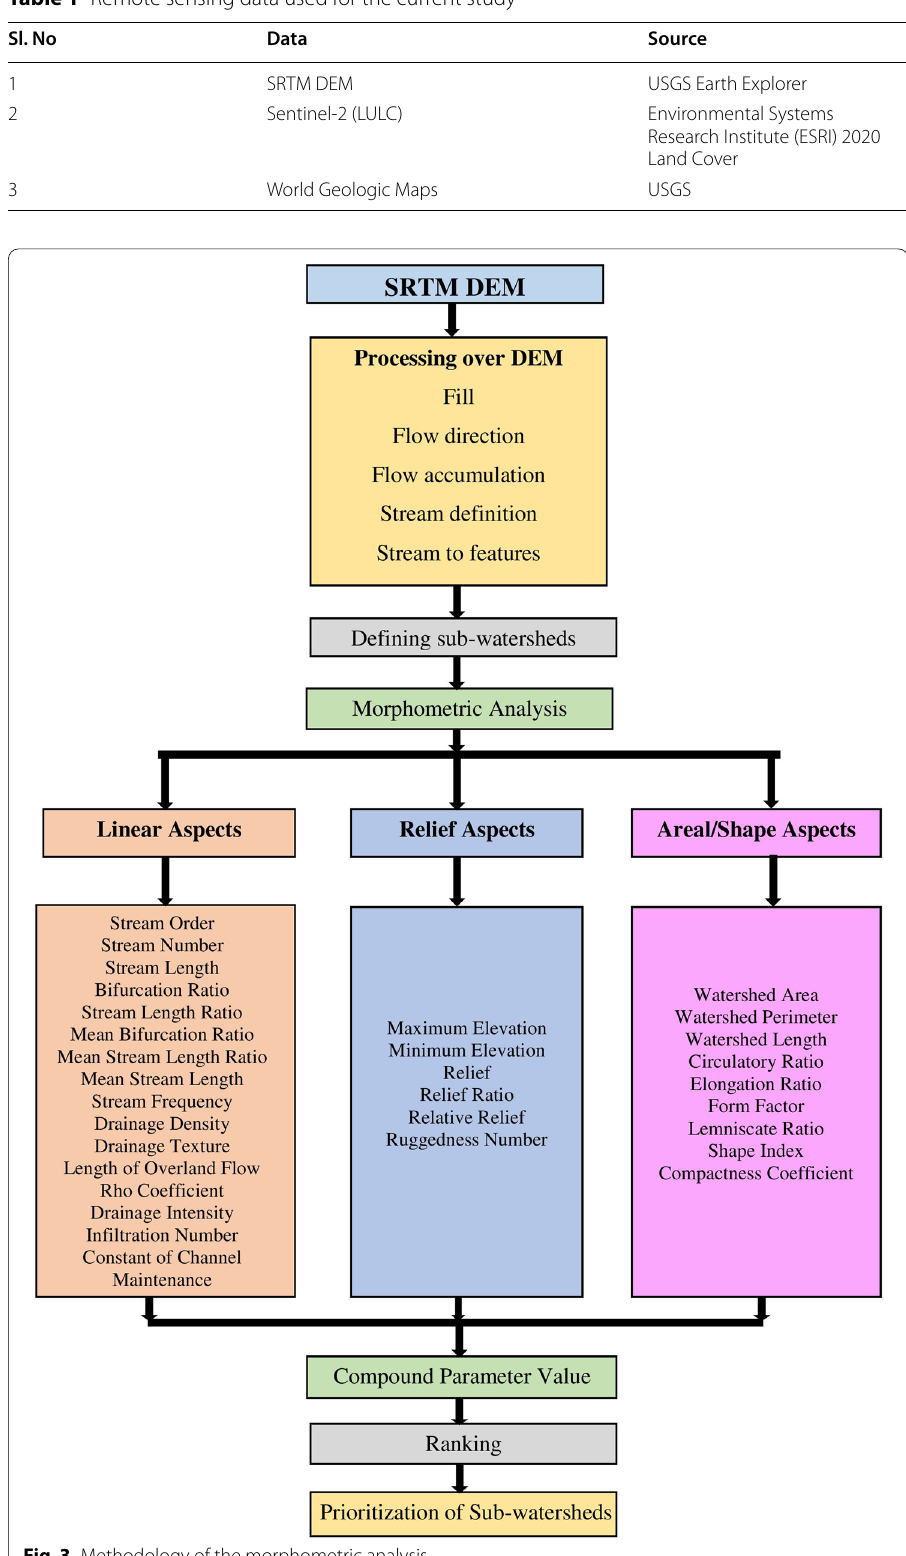
Fig. 3 Methodology of the morphometric